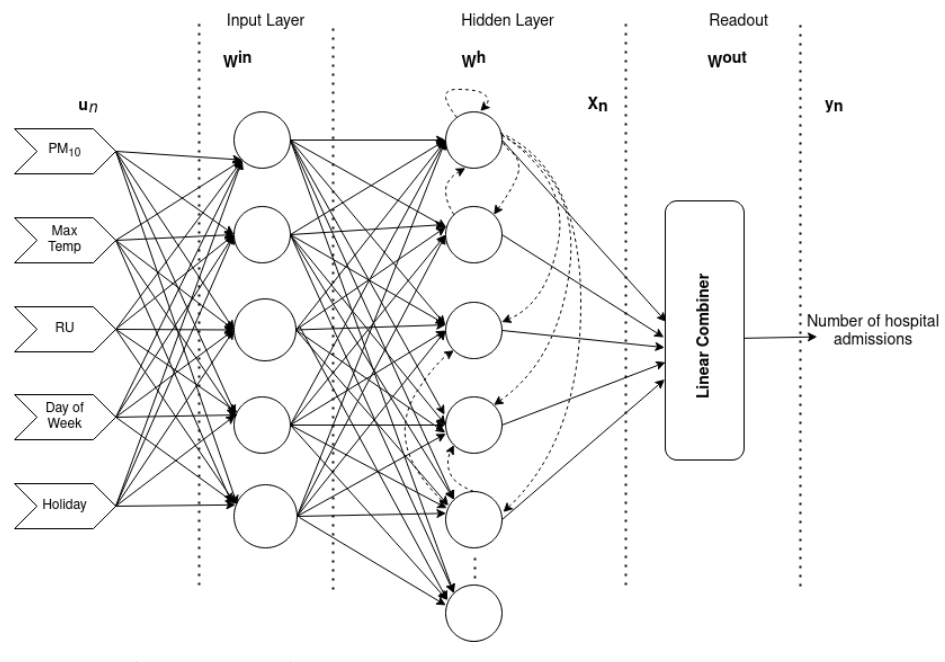
Figure 2. Echo state